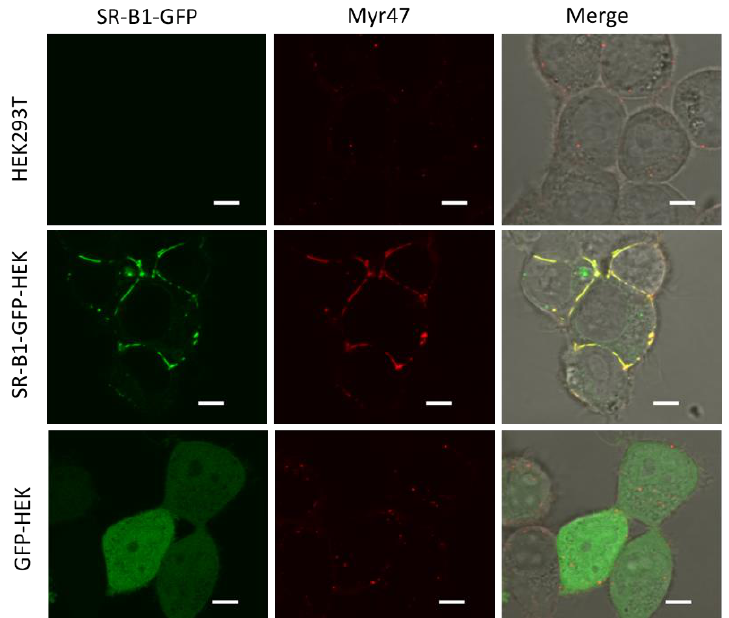
Figure 3. Colocalization of Myr47 and SR-B1-GFP at the surface of SR-B1-GFP-HEK cells. Myr47 binding in HEK293T (upper line), SR-B1-GFP-HEK (middle line), and GFP-HEK cells (bottom line) were observed under LSM. The fluorescence of GFP and Alexa 647-labeled Myr47 is shown in green and red, respectively; Merge: GFP and Myr47 fluorescence and bright filed images are overlaid. Bars indicate 5 μ m.